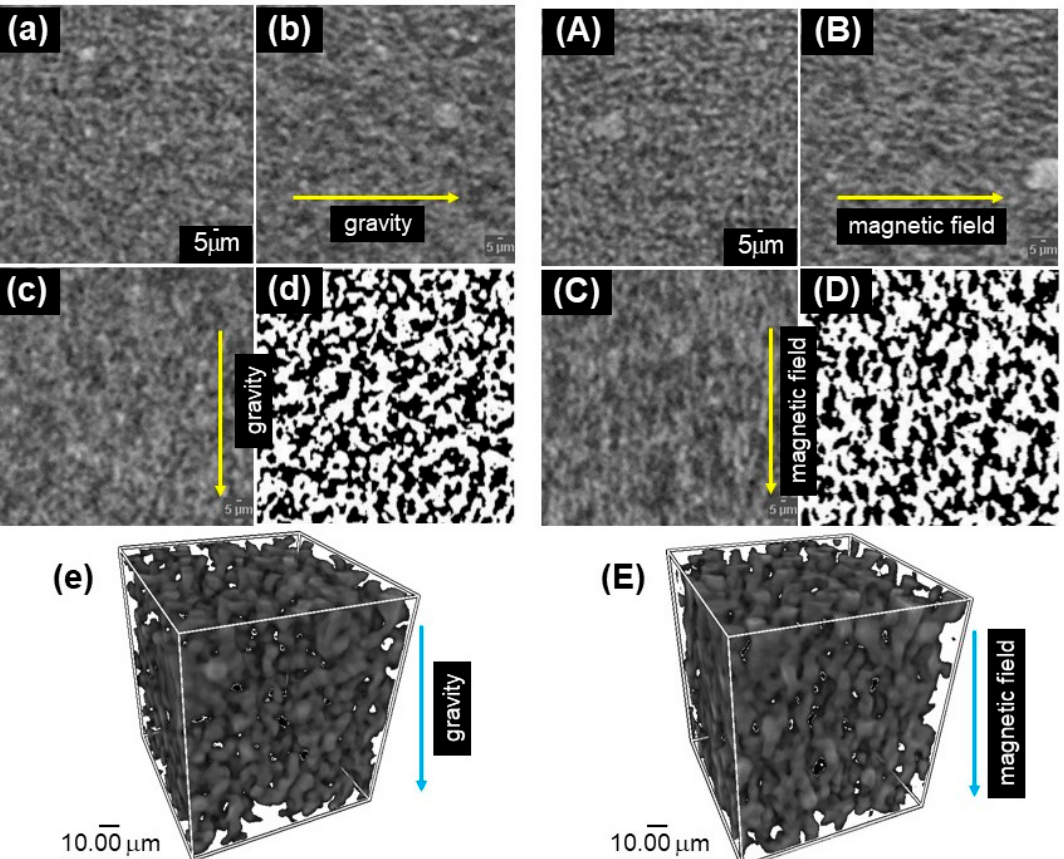
Figure 4. CT images for magnetic elastomers at ( a – e ) 0 mT and ( A – E ) 270 mT with different views; ( a , A ) top, ( b , B ) side, ( c , C ) front, and ( e, E ) 3D view. The directions of gravity and magnetic field are indicated by arrows. ( d , D ) Black-and-white images of the side view (CI 70 wt%, DOP 70 wt%).